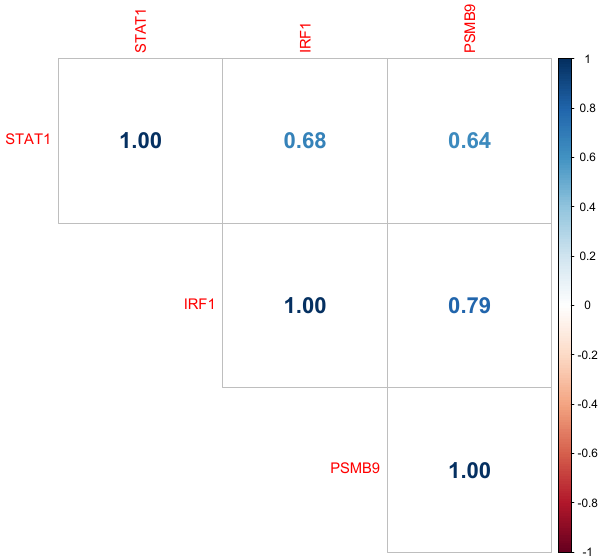
Figure 4. Correlation matrix of genes related to IFN γ signaling through the JAK/STAT1 pathway in all uLMS samples in the 1st and 4th quartiles. All values inside each cell correspond to Pearson correlation coefficient at the 0.05 level.